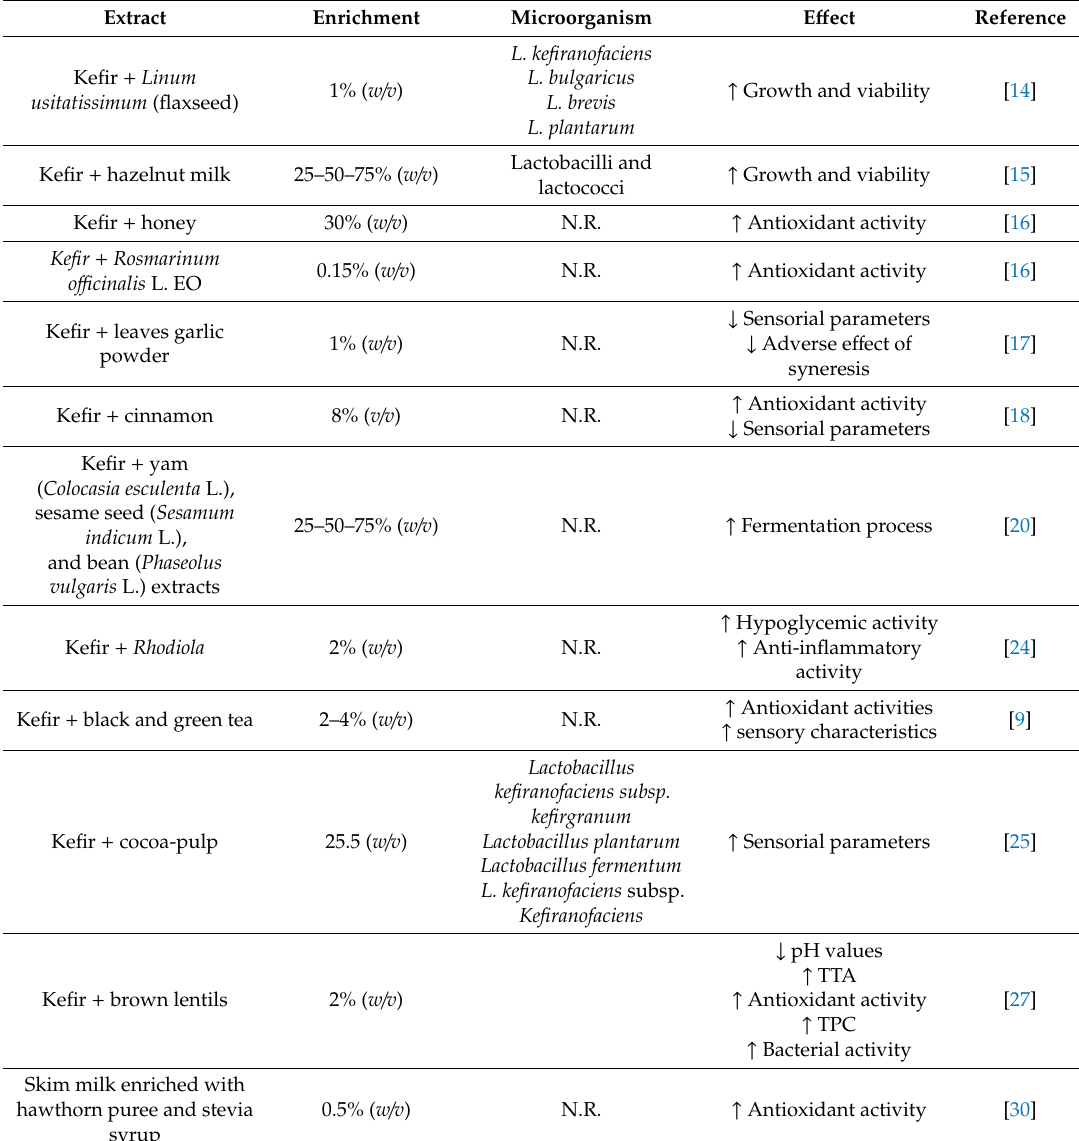
Table 1. Kefir enrichment with plant